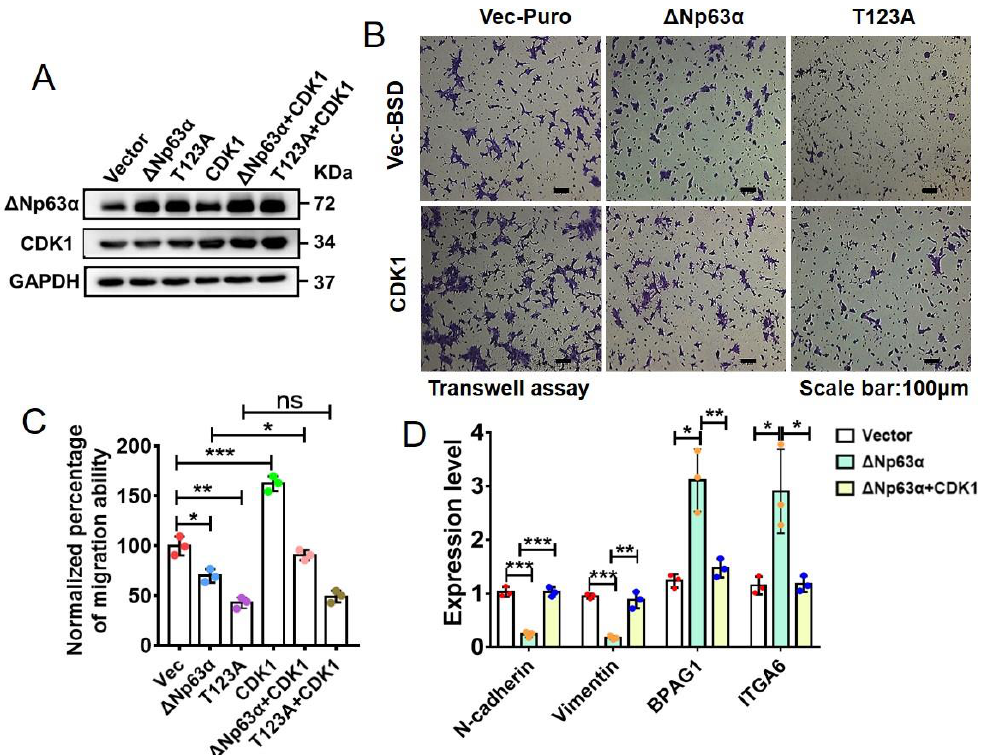
Figure 6. CDK1 impairs inhibitions of HNSCC cell EMT and migration induced by wild-type ∆ Np63 α but not those by its T123A mutant. ( A ) UM1 cells overexpressing CDK1 and (or) ∆ Np63 α were constructed with lentiviral infection and identified by means of IB analysis. ( B ) UM1 cells overexpressing CDK1 and (or) ∆Np63α were subjected to transwell assay. Representative crystal violet staining images of migrated cells on the underside were shown. ( C ) Quantification of effects of CDK1 and (or) ∆Np63α overexpression or ablation on migration ability bas ed on transwell assays (means ± SD, n = 3). One-way ANOVA test was used for comparison between two groups. *** , p < 0.001; **, p < 0.01. ( D ) The abovementioned cell lines were subjected to RT-qPCR analysis to measure mRNA levels of N-cadherin, vimentin, BPAG and ITGA6 (normalized with GAPDH). The qPCR data are presented as means ± SD (n = 3). *** , p < 0.001; **, p < 0.01; * , p < 0.05.